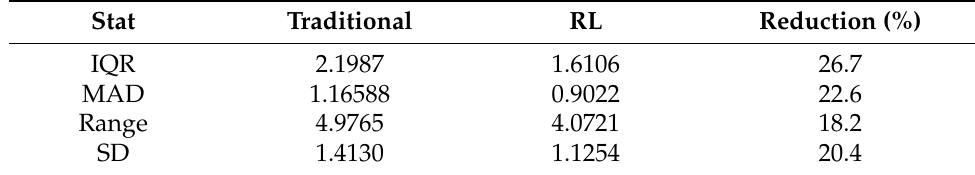
Table 6. The statistics dispersion results on the REFIT